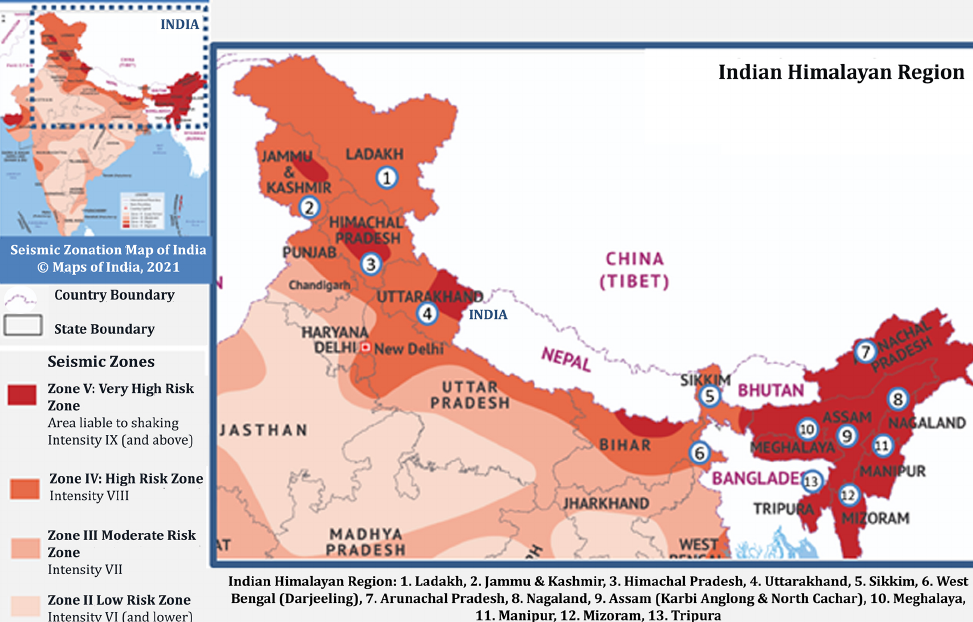
Figure 3. Seismic zonation map of India; source: adapted from © Maps of India (https://www.mapsofindia.com/maps/india/seismiczone.htm, last access: 1 April